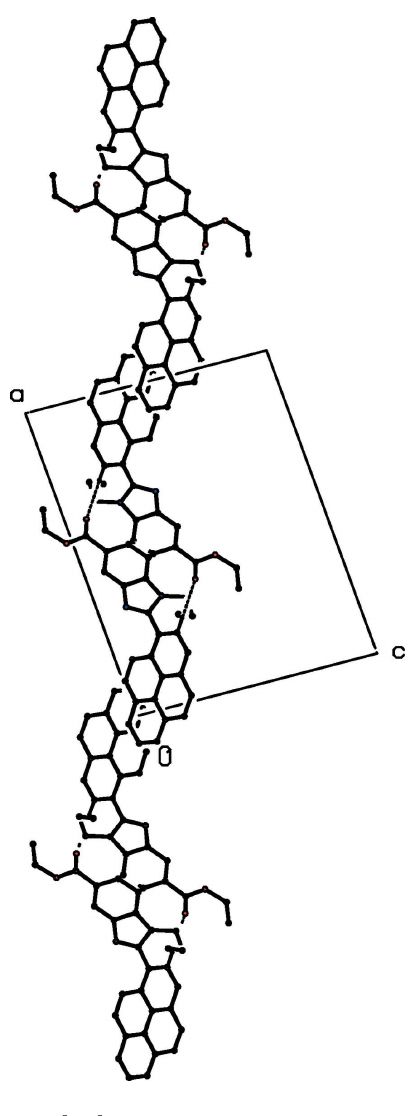
Figure 6 A projection along [010] of part of the crystal structure of compound (II) showing the formation of a (cid:2) -stacked sheet of hydrogen-bonded chains. Hydrogen bonds are drawn as dashed lines and, for the sake of clarity, the H atoms not involved in the hydrogen bonding have been